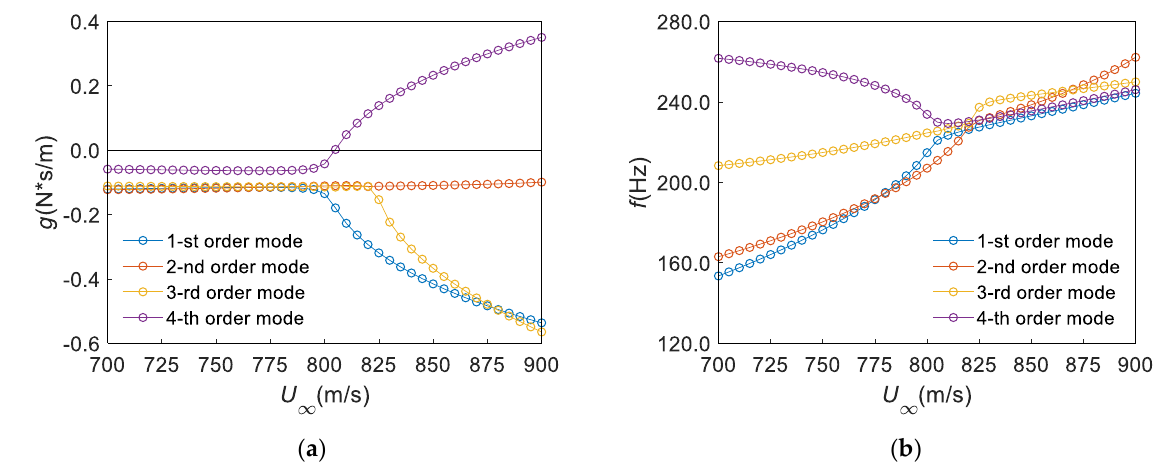
Figure 21. Results of flutter calculation for the panel with no mass attachment (NP) ( Ma ∞ = 2.0):